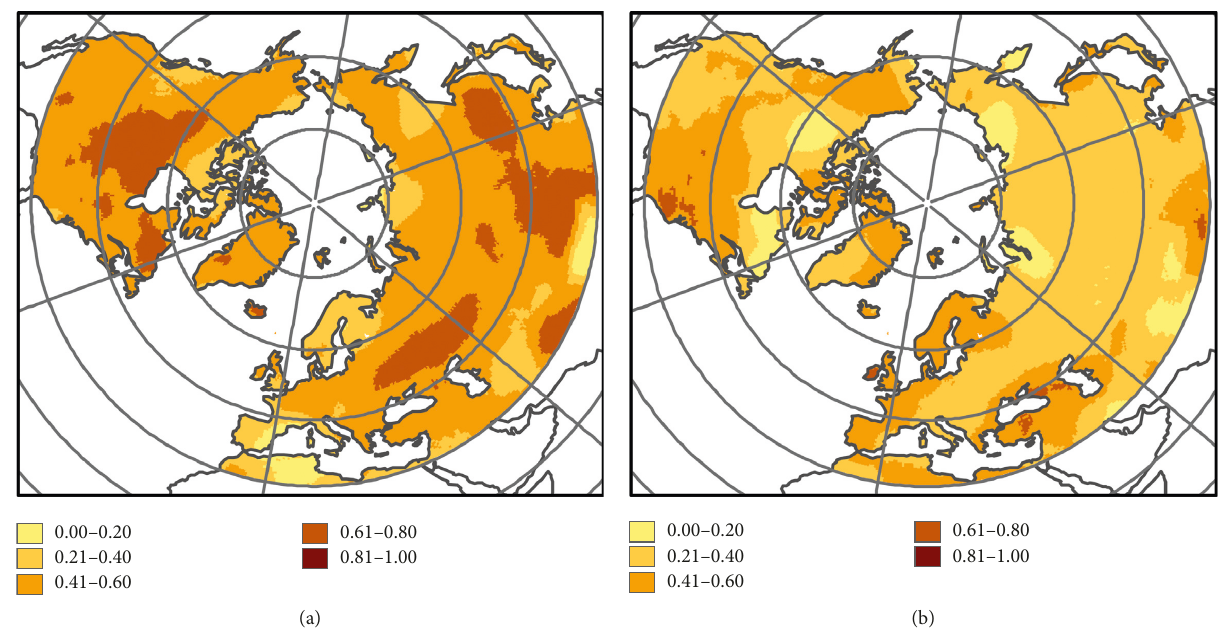
Figure 3: The determination coefficient ( R 2 ) between Kerner’s Oceanity Index (KOI) and the average temperature in (a) April ( T ) in October ( T oct